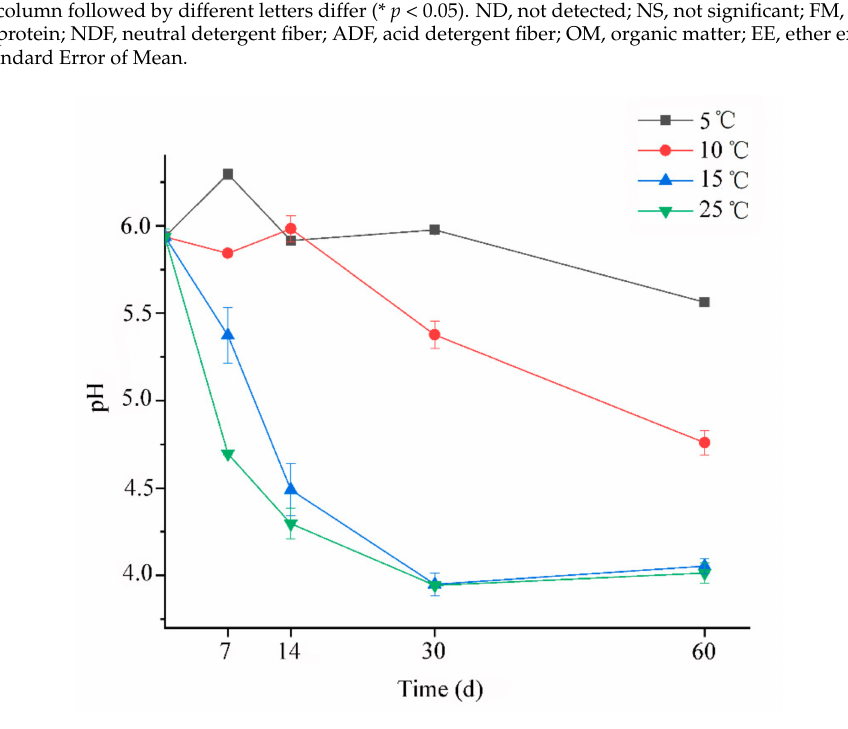
Figure 1. The change of pH for oat silages at different